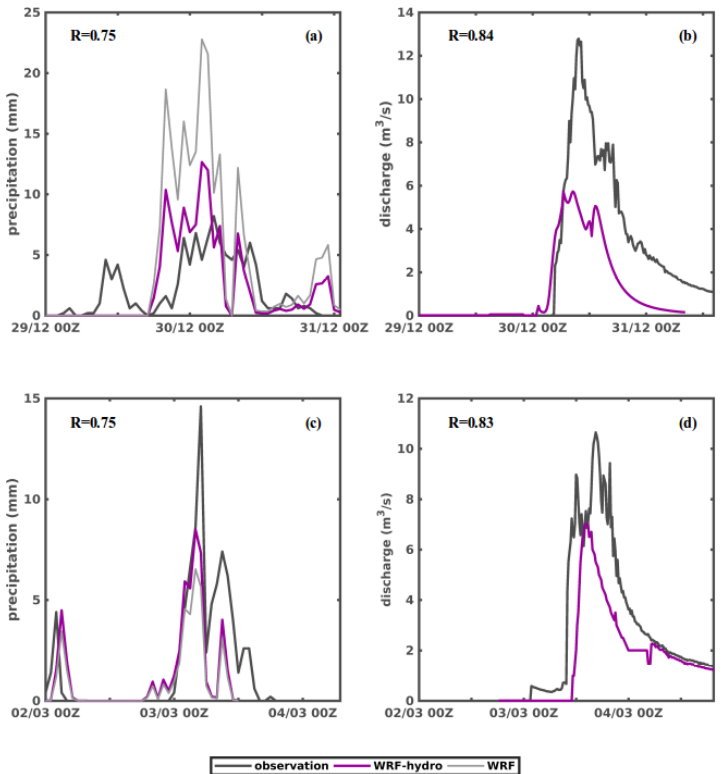
Figure 5. The temporal distribution of the observed and simulated (a) precipitation and (b) discharge for event 4S and the same variables (c, d) for event 6.